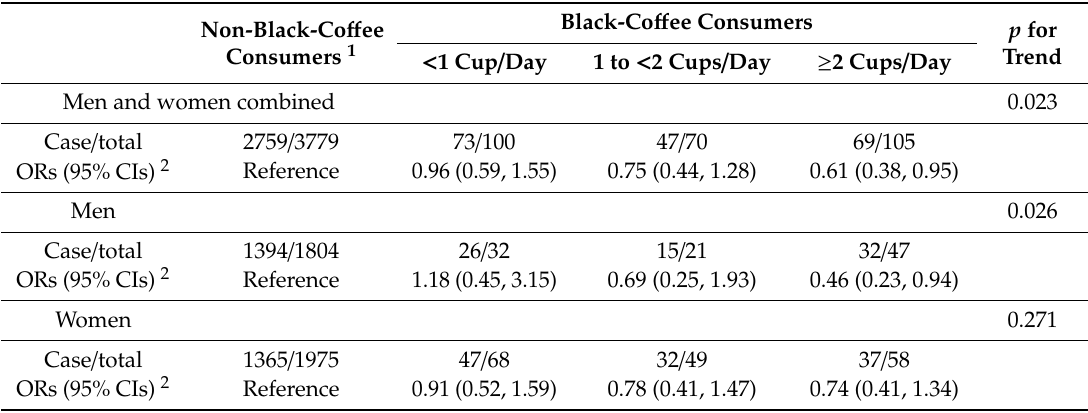
Table 3. Multivariate-adjusted ORs and 95% CIs for the risk of prediabetes and type 2 diabetes combined according to black co ff ee consumption.